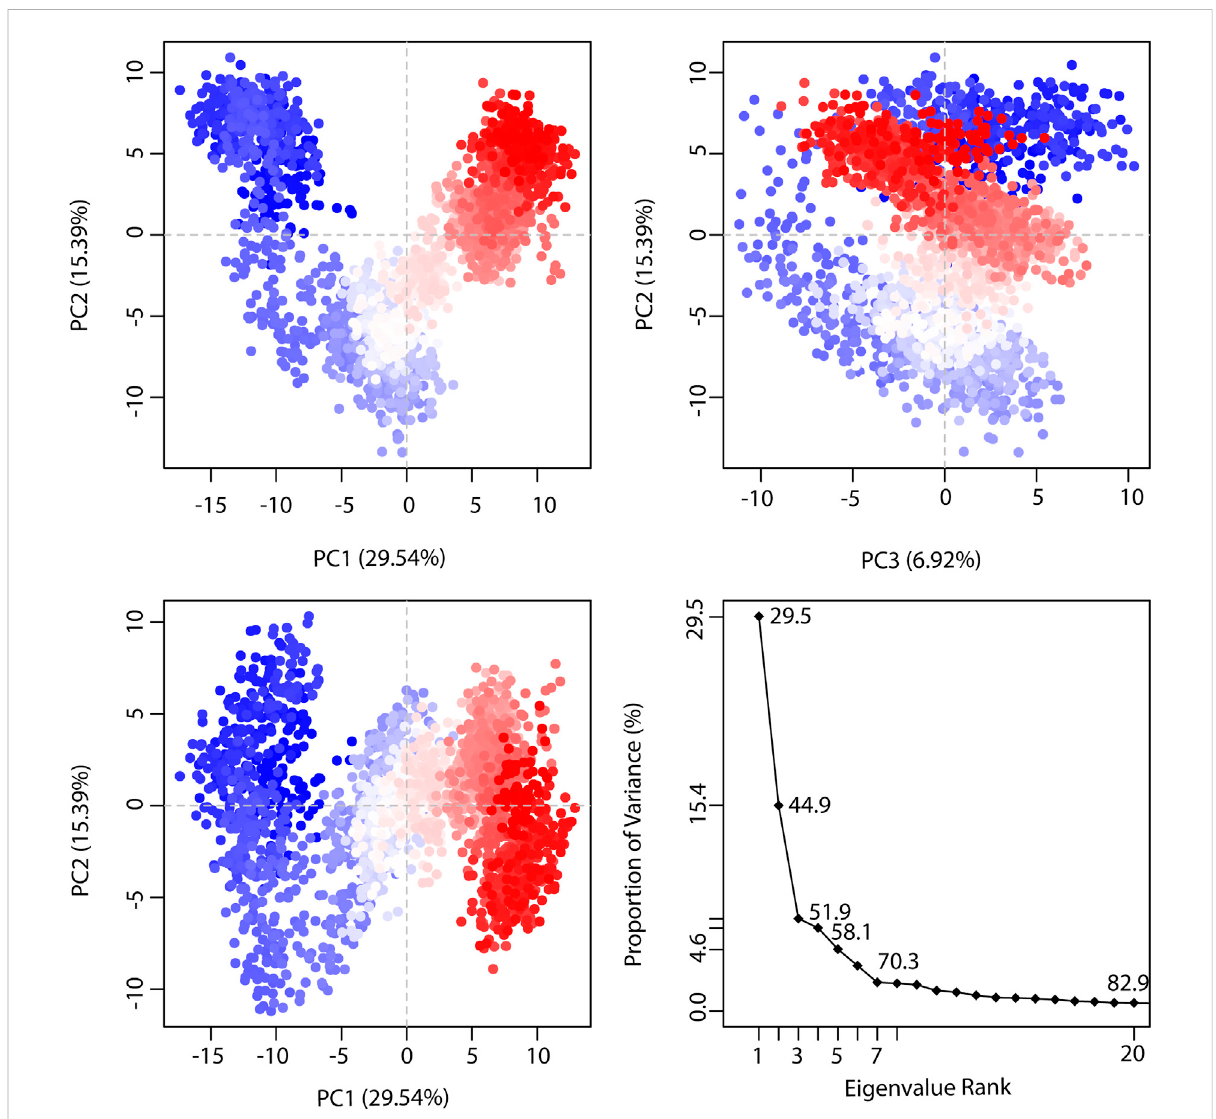
FIGURE 10 The representation of proportion of variance % (TTK-NDC1) against eigenvalue calculated by Principal Component Analysis. Three PCs are showing the fl uctuating regions. The fl uctuations in PC1, PC2, and PC3 are 29.54%, 15.39% and 6.92% respectively. The overall fl uctuations are